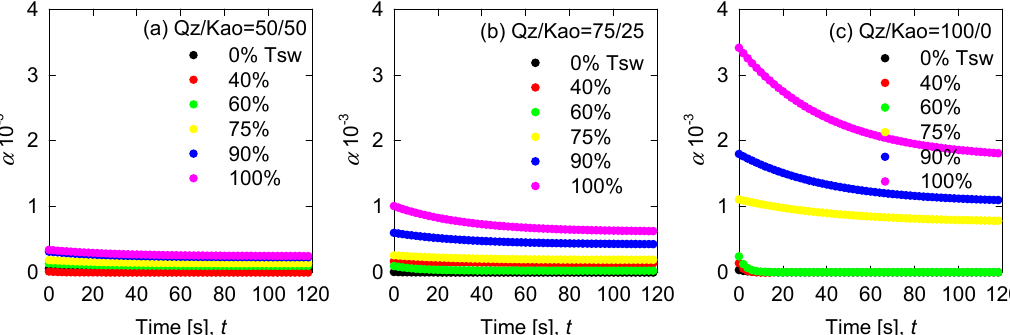
Figure 5. Collision efficiency for the mean chord length over time. Quartz/Kaolinite ratio ( a ) 50/50; ( b ) 75/25; ( c ) 100/0.